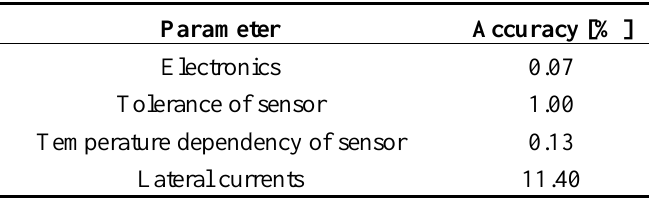
Table 2. Accuracies of the measurement system